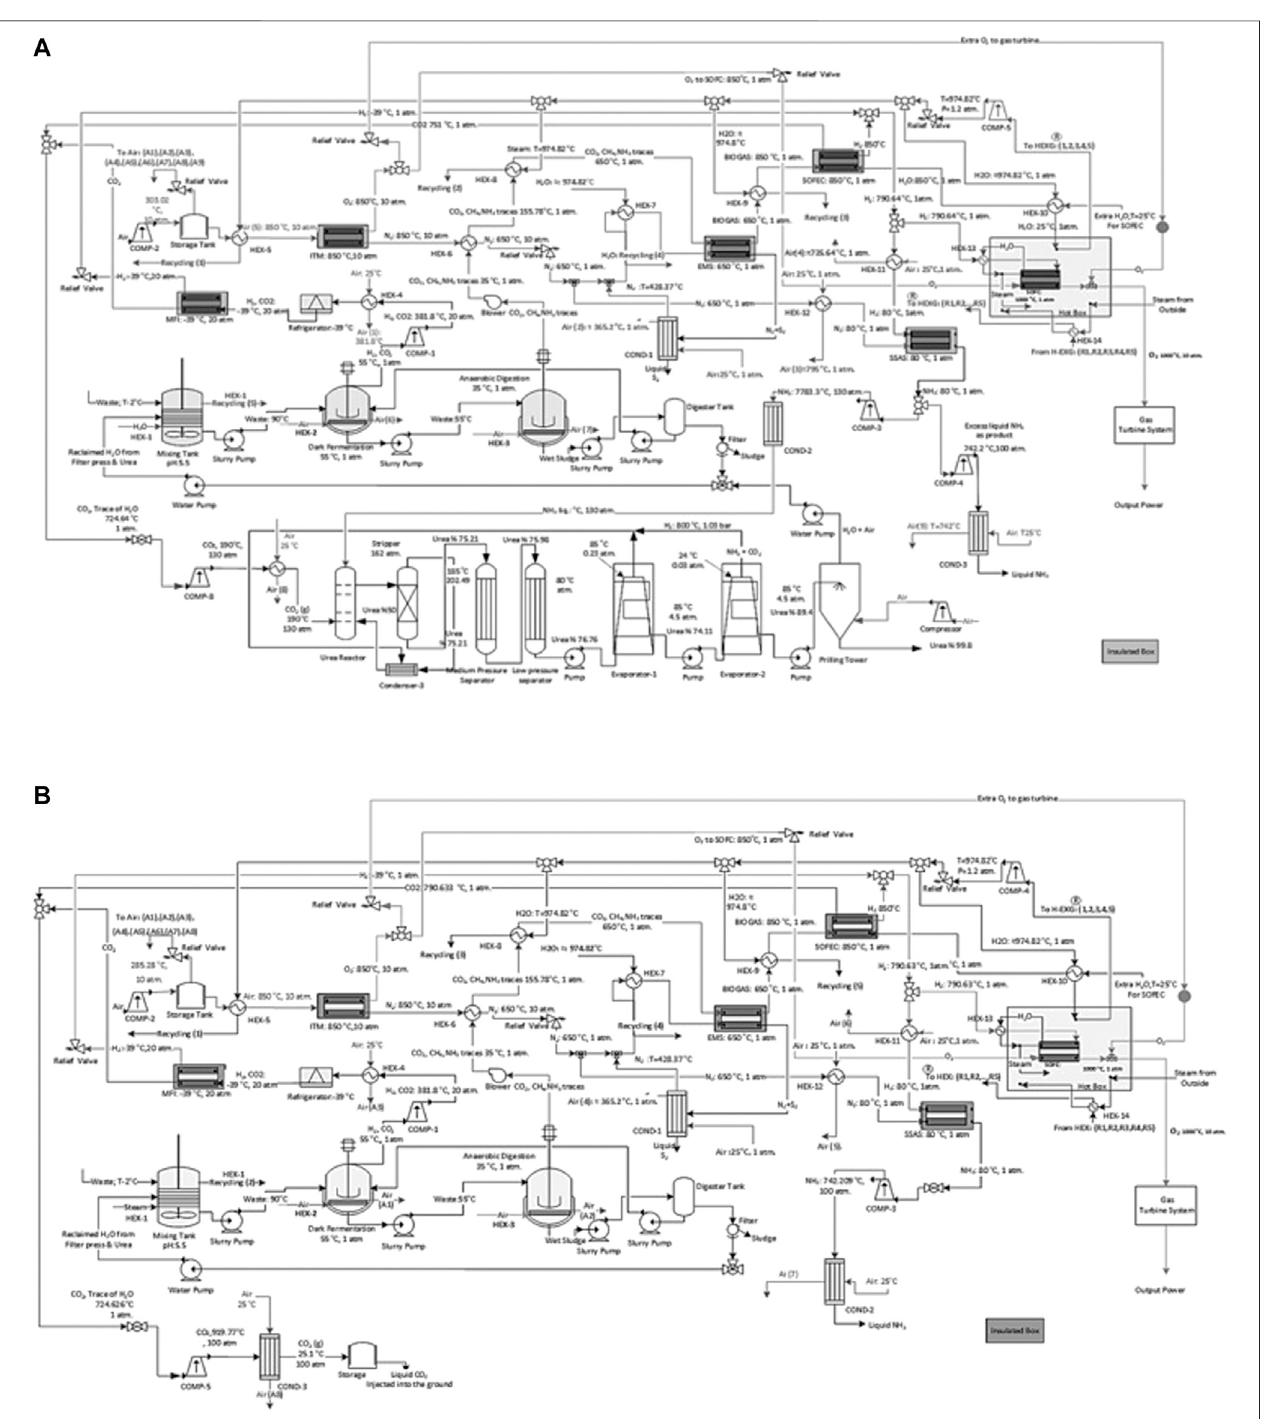
FIGURE6| Aschematicoftheprocess fl owdiagramoftheproposedammoniaproductionprocessthrough, (A) atwo-stageDFcoupledwithADwithureaproductionand by incorporating SOFC and (B) a two-stage DF coupled with AD without urea production with CCS and by incorporating SOFC.